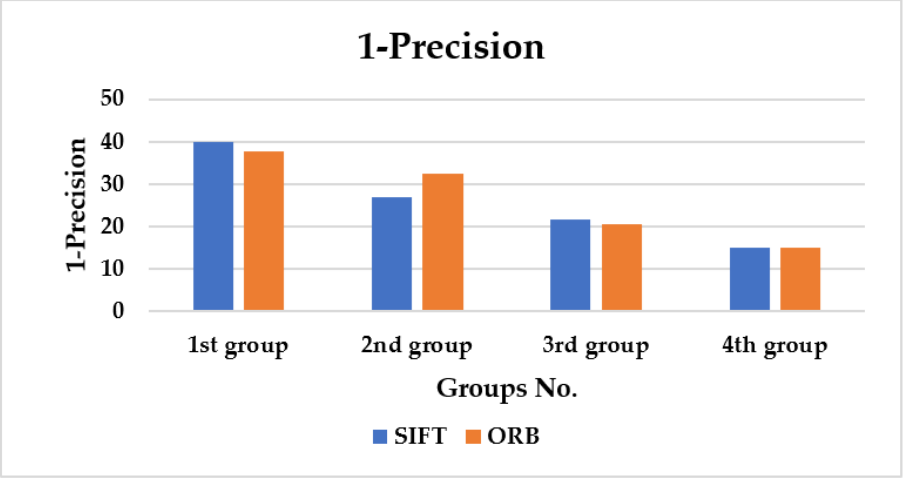
Figure 24. Computed 1-precision for the four groups created from TU Berlin dataset for methods based on handcrafted features. Table 2. Computed performance metrics for methods based on handcrafted features over the four groups of the ImageNet-Sketch dataset.